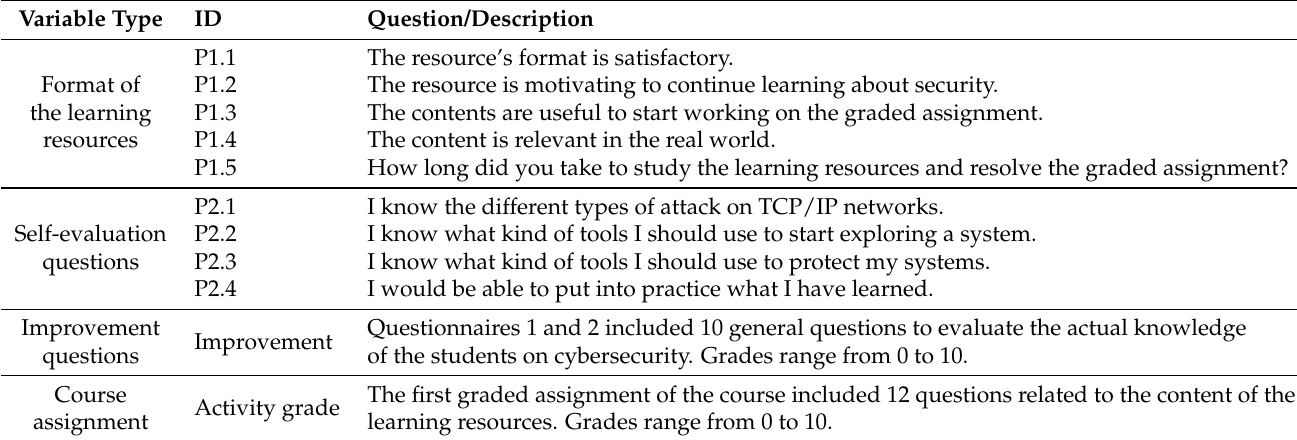
Table 1. Variables included included in this